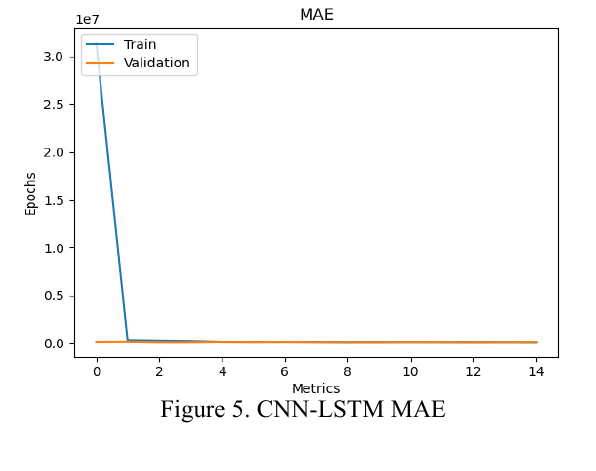
Figure 5. CNN-LSTM MAE